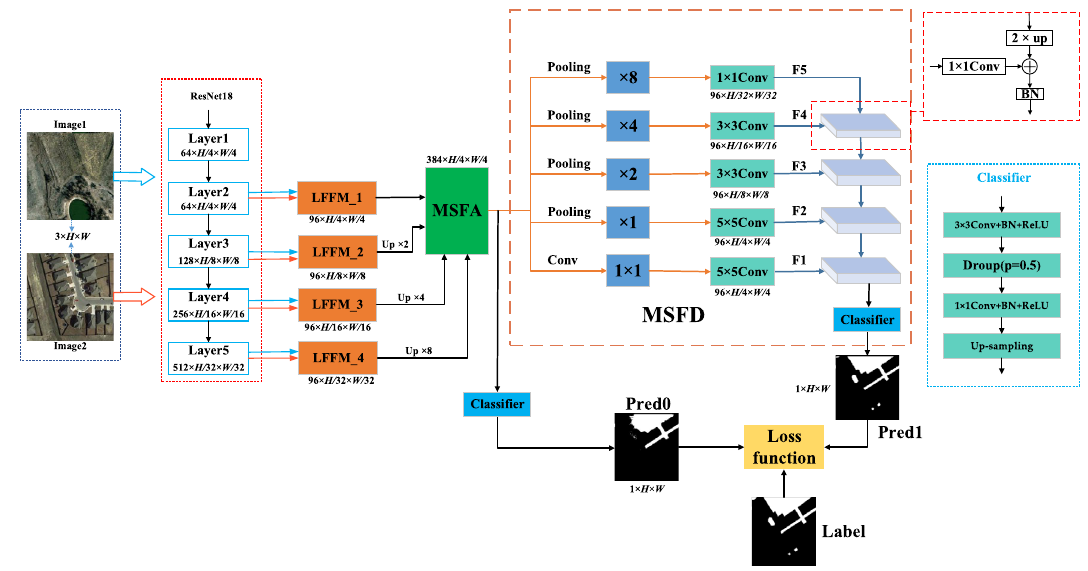
Figure 1. Framework of the MFPF-Net network (created by ‘Microsoft Office Visio 2013’ url: https:// www. micro soft. com/ zh- cn/ micro soft- 365/ previ ous- versi ons/ micro soft- visio-